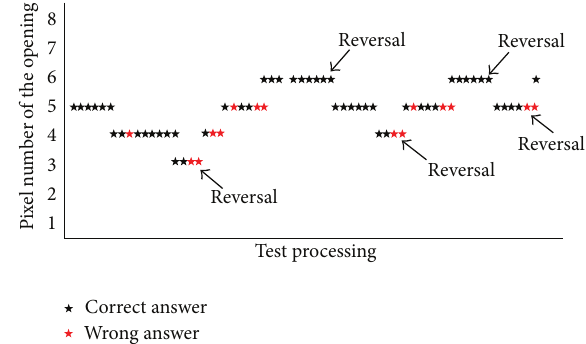
Figure 2: An example of the 6-down-2-up staircase paradigm. It started at an opening size of 5 pixels, went up and down in 1 pixel step, and stopped when reaching the 5th reversals along the test procedure. The logarithms of the visual angles at these 5 reversals were averaged to give an estimate of visual acuity at this training. On a 19-inch 16: 9 screen set at 1366 × 768 resolution, one pixel was equivalent to 160sec of arc when viewed at 40cm test